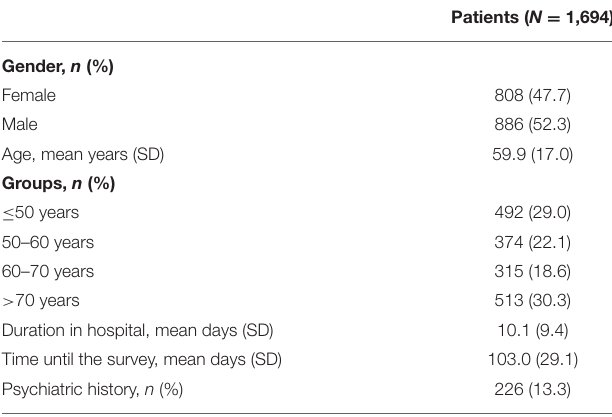
TABLE 1 | Sociodemographic characteristics of the